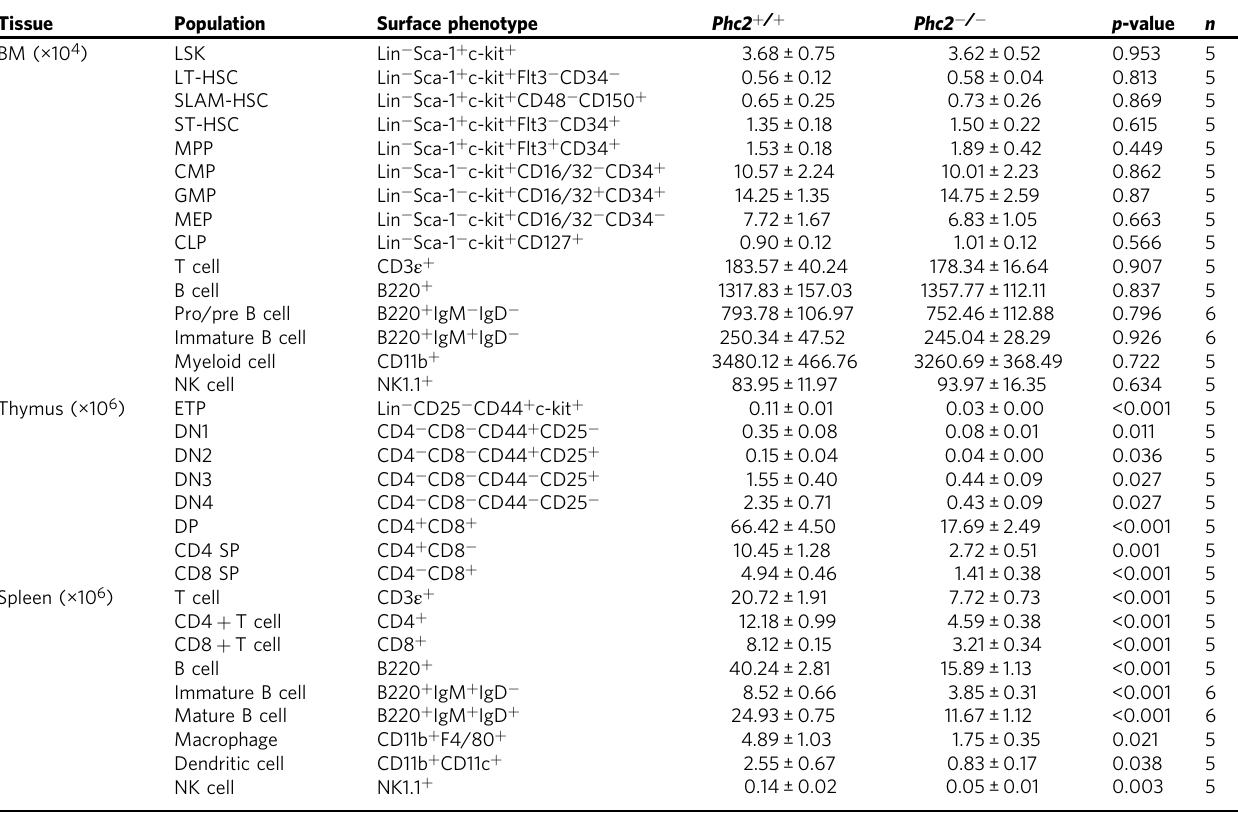
Table 1 Absolute numbers of immune cells and their precursors in Phc2 + / + and Phc2 − / − mice a